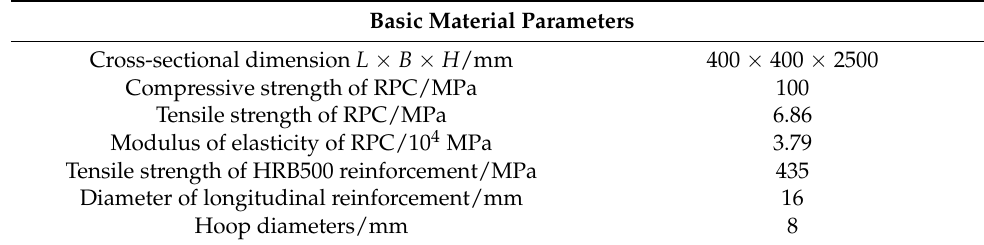
Table 7. Calculation parameters of typical RPC